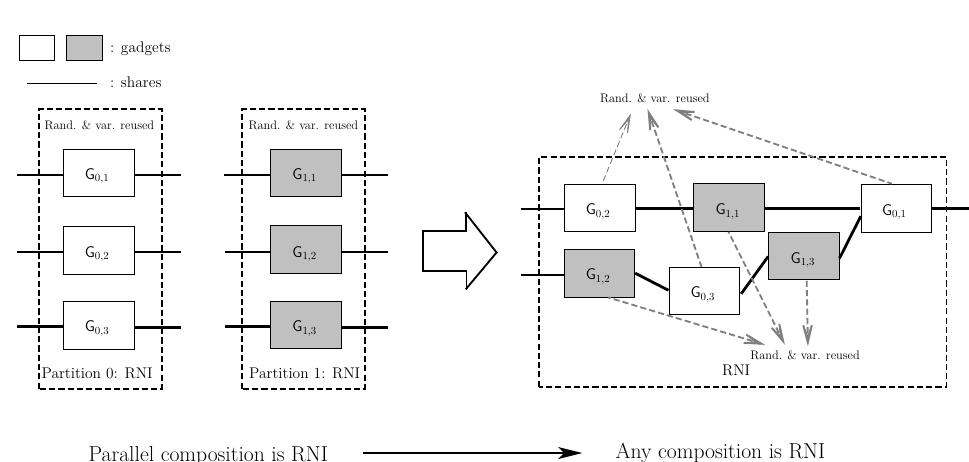
Figure 4: An arbitrary composition (on the right) that can be described a bipartite graph is RNI, as long as the parallel compositions (on the left) of gadgets in each partition is